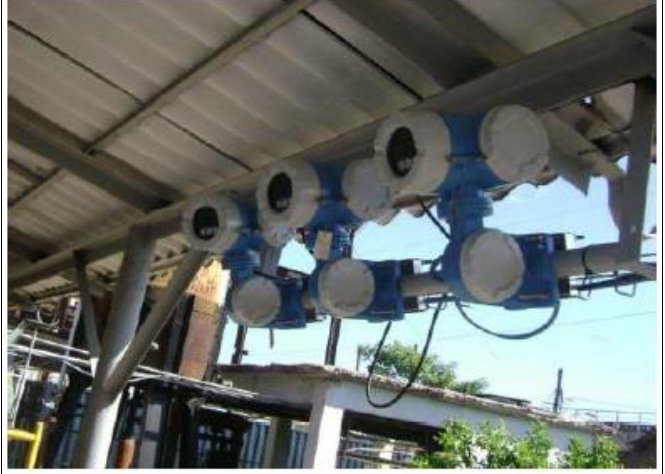
Figura 2: TankSide Monitor NRF590, instalados en el campo. Fuente: Los Autores, (2015).